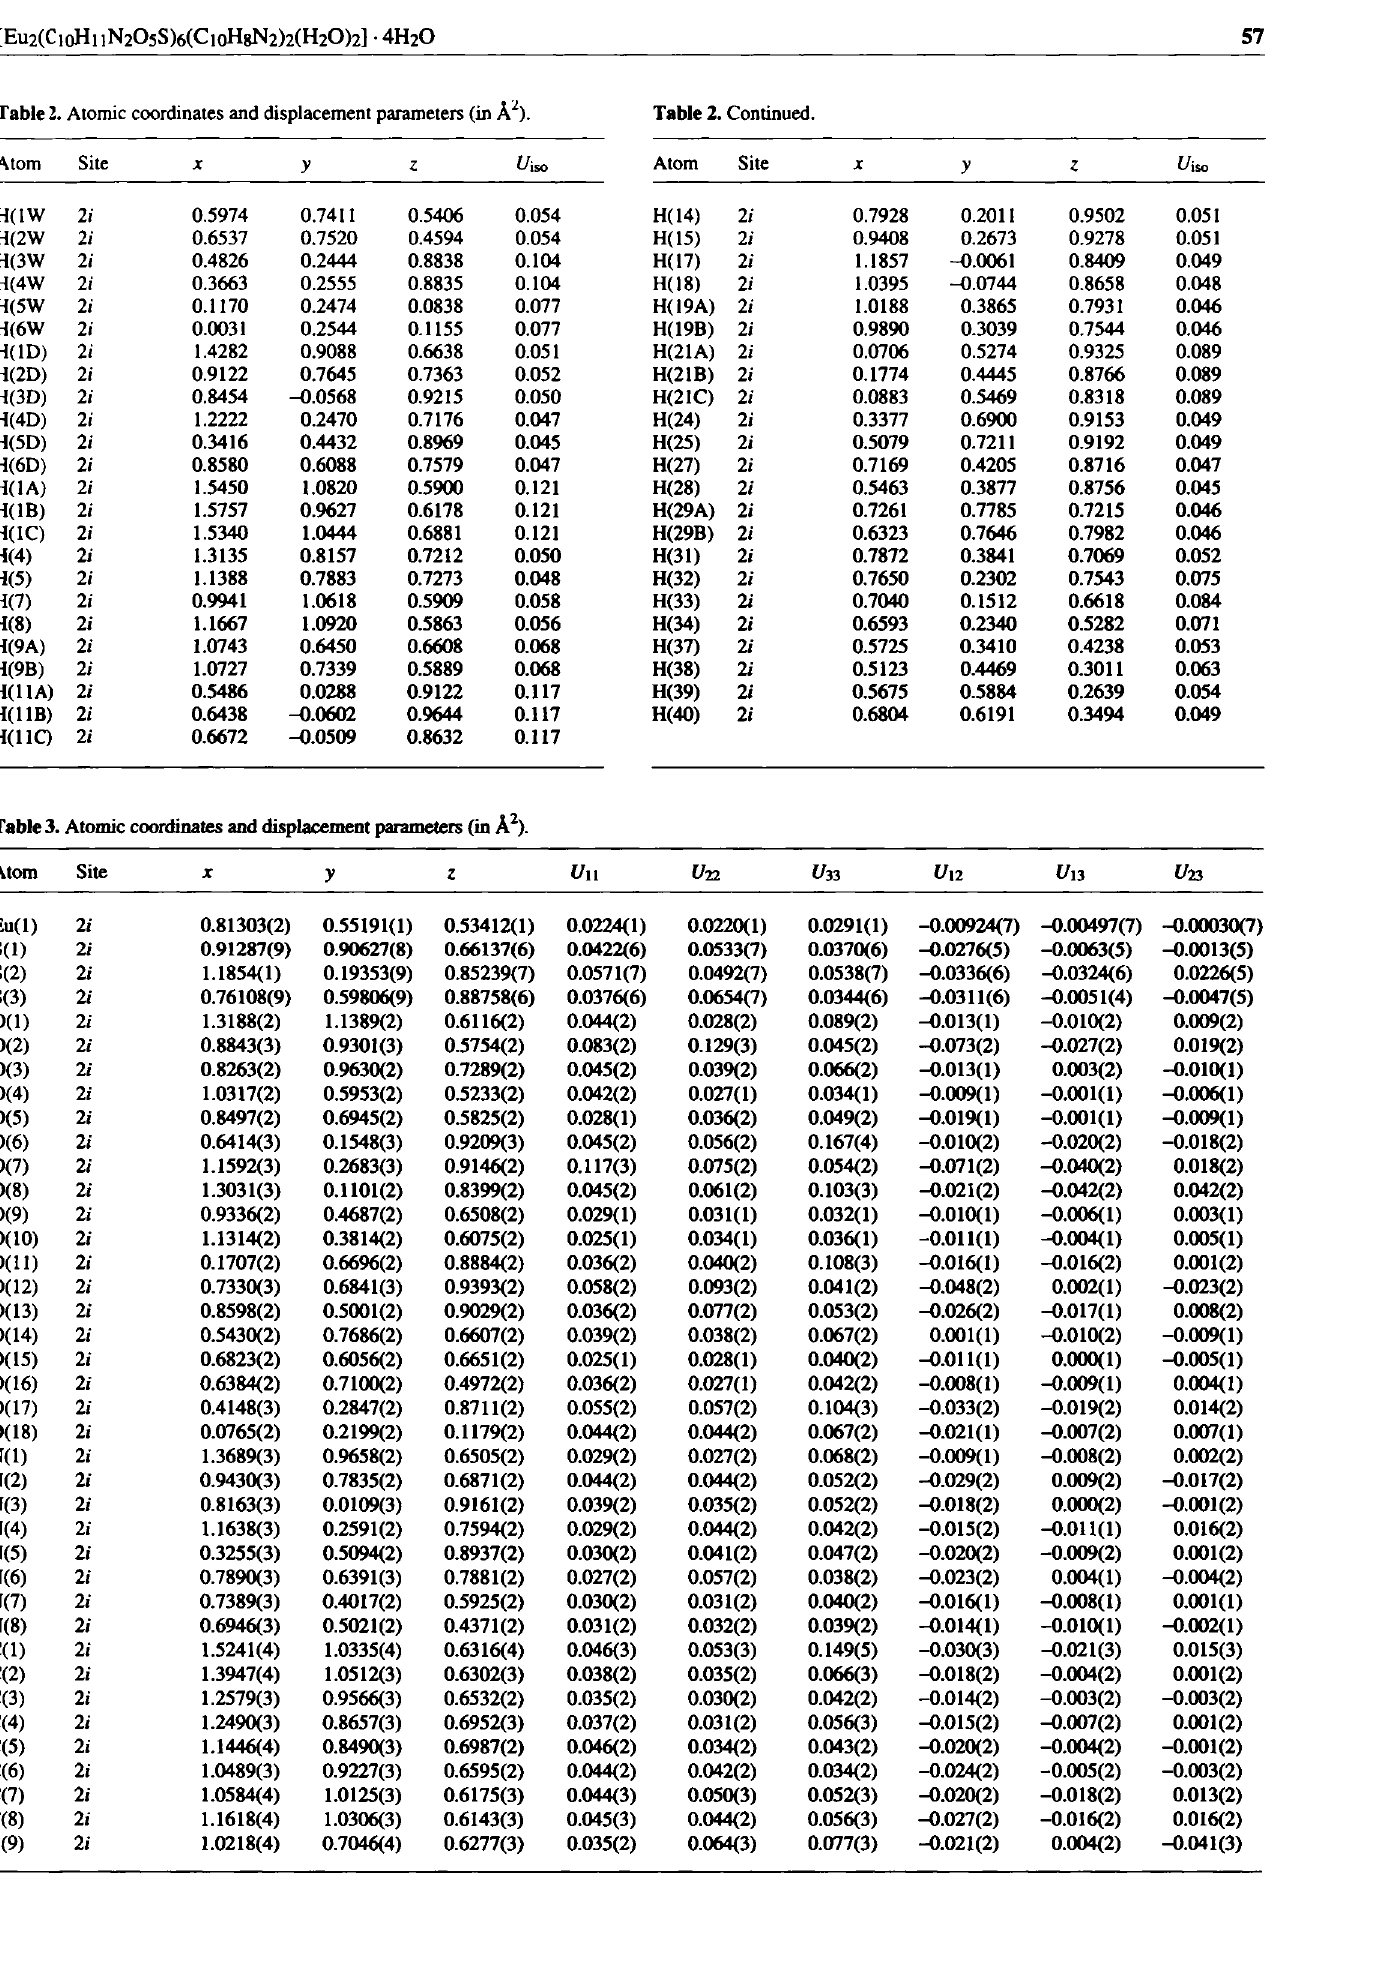
Table 3. Atomic coordinates and displacement parameters (in À 2